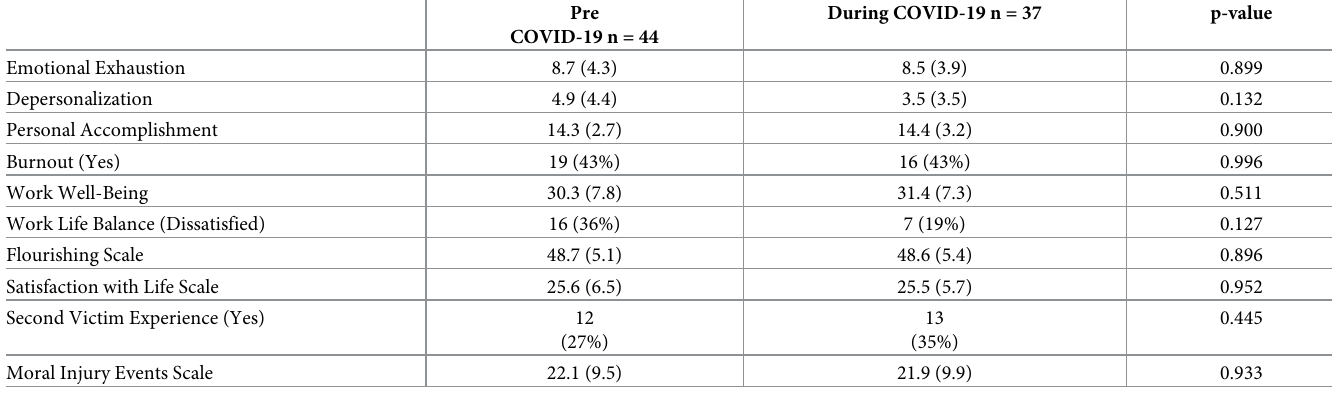
Table 2. Distress, burnout and well-being for hospitalists pre and during COVID-19.